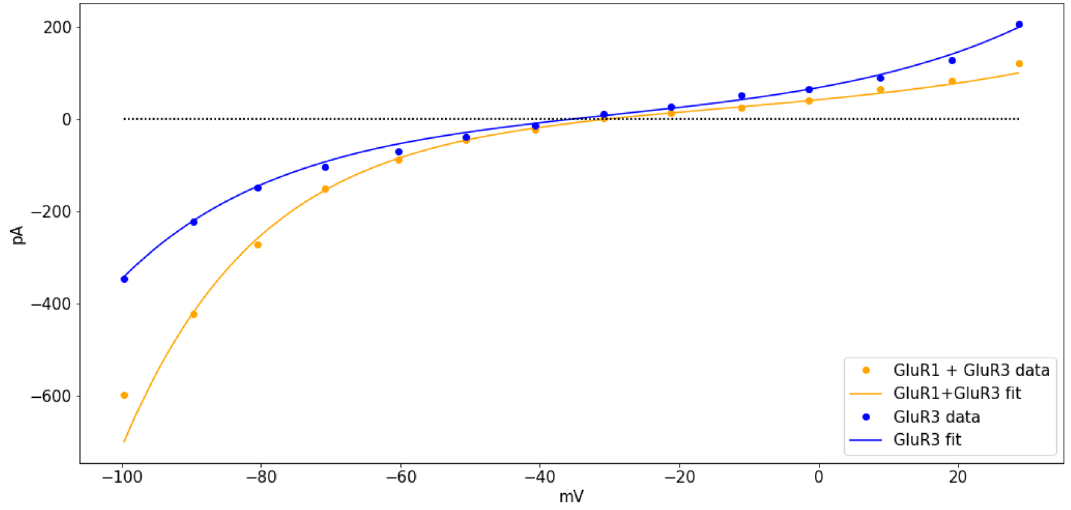
Figure 3. Currents mediated by AMPA-Kainate receptors with different ionic permeabilities (different reversal potentials) and different degrees of rectification caused by differences in the sub-unit composition of the receptors. Currents were recorded from oocytes injected with GluR3 cRNA (blue), or a combination of GluR1 and GluR3 cRNA (orange), in Ca 2+ ringer solution after activation by AMPA. The curves were fit with( v , b , r q) = ( − 30, 0.45, 21), for GluR3 and ( v , b , r q) = ( − 35, 0.35, 20), for GluR1+GluR3. Data was digitised from o o Figure 3B in the article by Hollmann et al. (1991) (Table